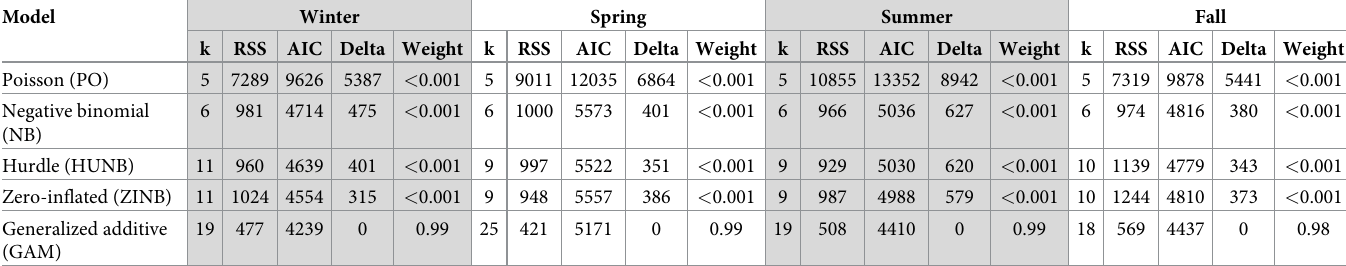
Table 2. Model comparison for the count data for different seasons. k = number of model parameters, RSS = residual sum of squares, weights = AIC weights, RMSD = root mean square deviation. Model